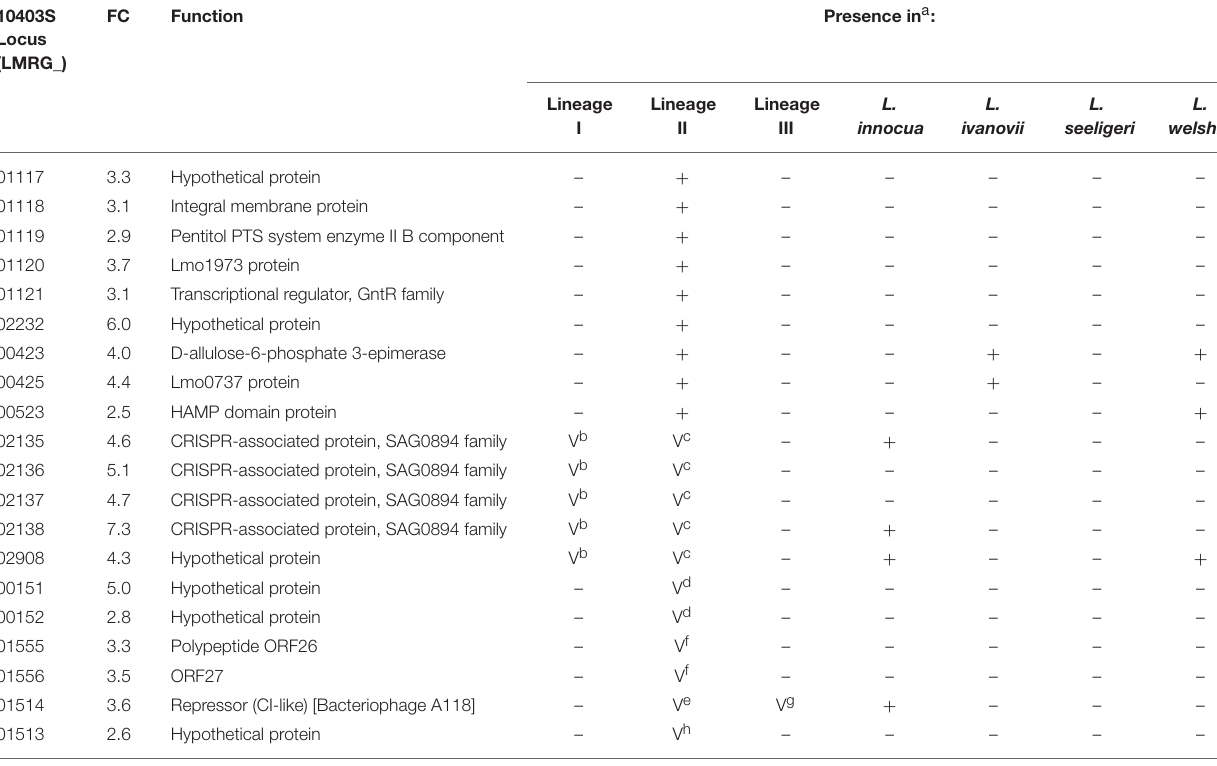
TABLE 2 | Genes upregulated by bile in 10403S with no homolog in H7858. 10403S